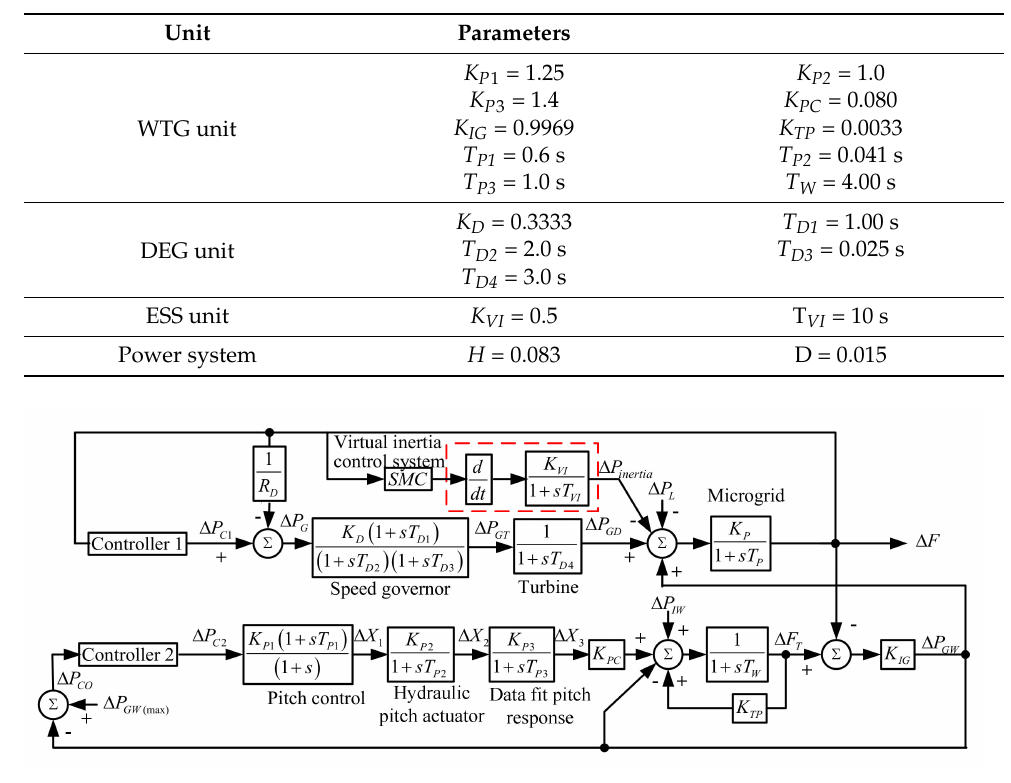
Figure 1. Dynamic model of the HPSREG